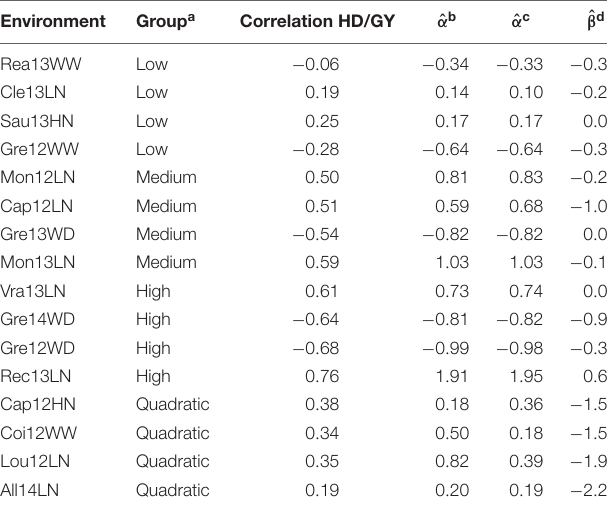
TABLE 1 | Description of the 16 environments selected for the analysis.